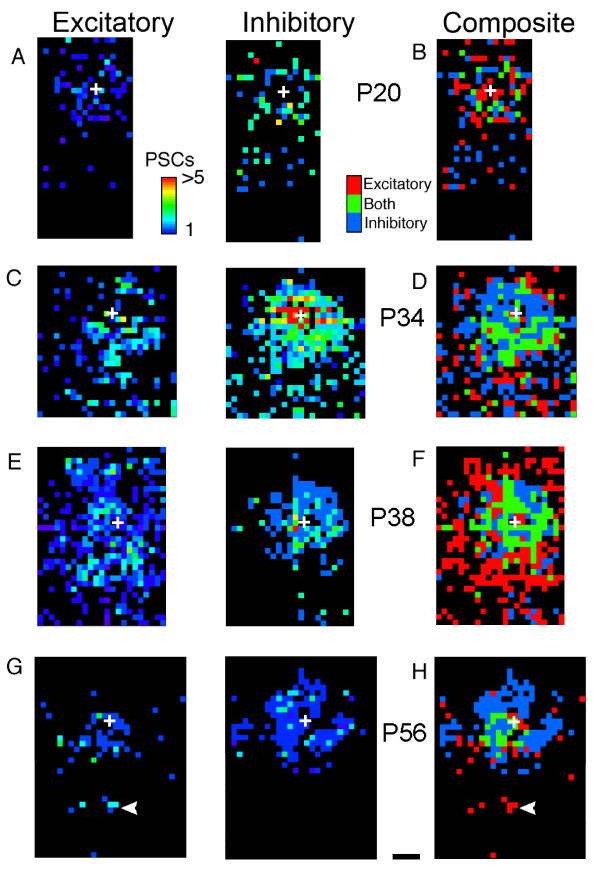
Changing patterns of inhibitory inputs and relationships between inhibitory and excitatory inputs at different postnatal ages. (A) Map of inhibitory inputs onto a P20 pyramidal neuron. The number of inputs is represented by the colored squares (scale bar at right); black indicates that no inputs were generated at that location (same scale applies for (C, E, G)). Relatively few sites generate inputs to this cell, and all are located within 500 μm of the cell body (indicated by the white cross). We stimulated 644 sites, mapping an area of approximately 1 mm2. PSC, post-synaptic current. (B) Map of the same cell in (A), but indicating sites that, when stimulated, generated excitatory (red), inhibitory (blue), or both (green) types of synaptic inputs (same convention applies to (B, D, F, H)). The number of events is not coded in these plots. Excitation dominates locally, as indicated by the red regions close to the cell. Inhibition dominates with increasing distance as indicated by the abundance of blue squares. (C) Example of the pattern of inhibitory inputs onto a P34 pyramidal neuron. Both the number of inputs and the area from which they arise have increased substantially compared to P20 to 22. The map consisted of 1,174 points covering 1.7 mm2. (D) At P34, inhibitory inputs predominate; close to the cell body stimulation evokes a mixture of excitatory and inhibitory inputs whereas at earlier ages (B) excitation dominated. (E) Map of inhibitory inputs into a P38 pyramidal neuron from 1,029 stimulation sites, covering an area of 1.4 mm2. At this age, the overall number of sites generating inhibitory inputs has declined; the decline is especially pronounced at longer ranges (>500 μm). (F) At P38, the pattern of excitatory and inhibitory inputs is also markedly different. Fewer sites generate exclusively inhibitory inputs, and longer range inputs are exclusively excitatory. (G) Map of a mature (P56) pyramidal neuron (1,019 points covering 2.3 mm2). The pattern of inhibitory inputs is similar to that seen at P38: most inhibitory post-synaptic currents are generated close to the neuron cell body. (H) The plot of excitatory and inhibitory inputs reveals significant changes in the pattern of excitatory inputs: far fewer are present than at P38 and those that are form occasional clusters (arrowhead). Scale bar (A-H), 250 μm.